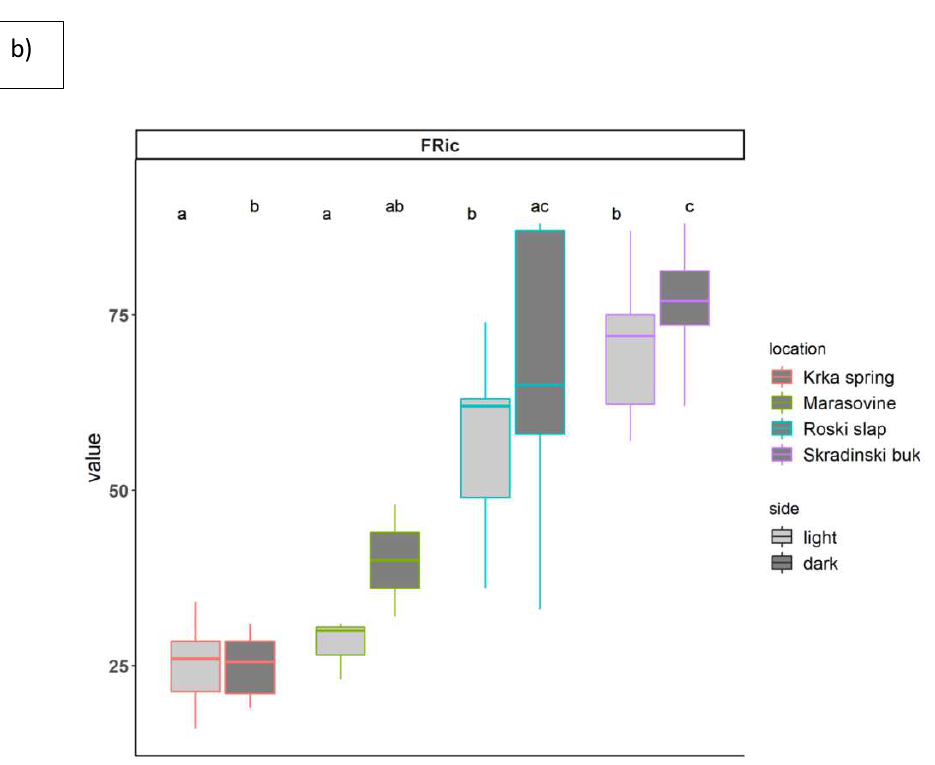
Figure 2. Changes in phylogenetic alpha diversity indices for PD—phylogenetic diversity and phylogenetic species variability index—PSV ( a ) and functional richness—FRic ( b ) visualised by boxplots for each sampling side and location; the horizontal thick black band represents the median values, and the boxplot margins indicate first and third quartiles, different letters above boxplots indicate significant differences among sampling side and location based on Tukey’s HSD test. The lighter grey colour denotes light-exposed samples, whilst darker grey colour denotes dark-exposed samples.